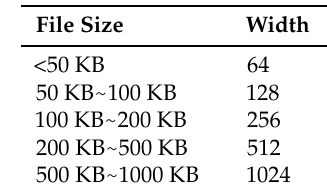
Table 1. Fixed Image Width According to File Size.